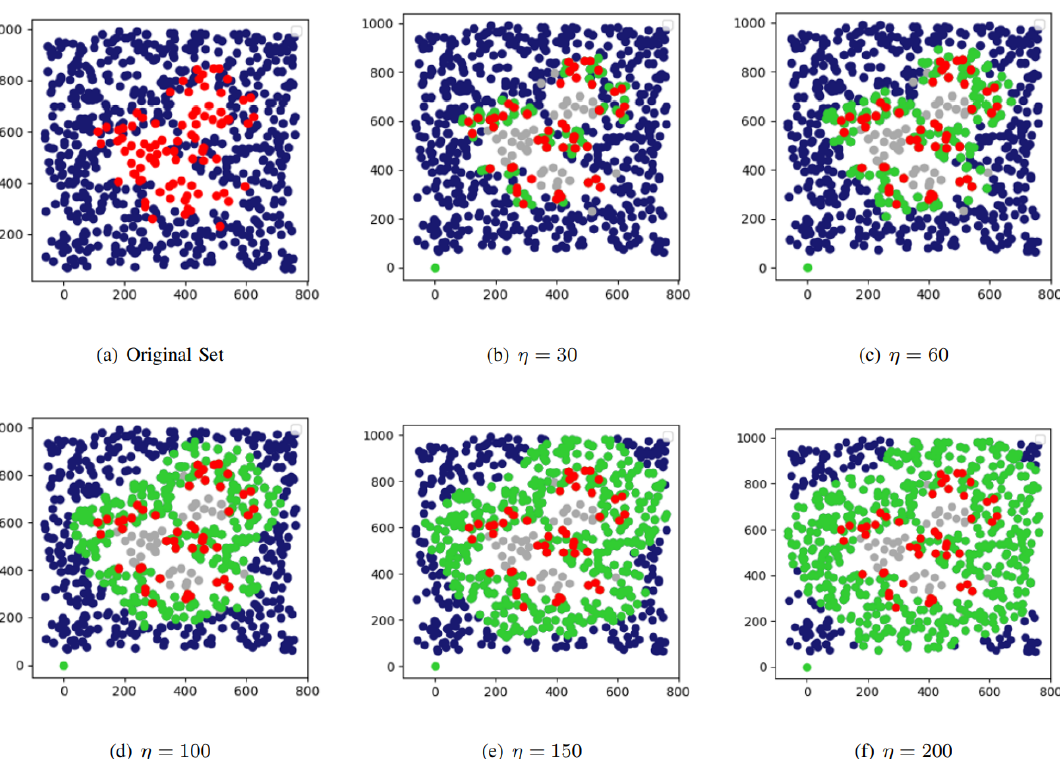
Figure 4. Data visual distribution for synthetic dataset paw50 with different η . Here, ( a ) is the original dataset; the red point is the minority class, and the blue point is the majority class. In ( b – f ), the red and gray points are the minority class samples in the entire dataset, whereas the green and blue points are the majority class samples in the entire dataset. The red points show the boundary domain. The gray points show the minority class with a clear decision boundary. The green points show the majority class selected by the DBRF algorithm. The green, red, and gray points form the density domain.